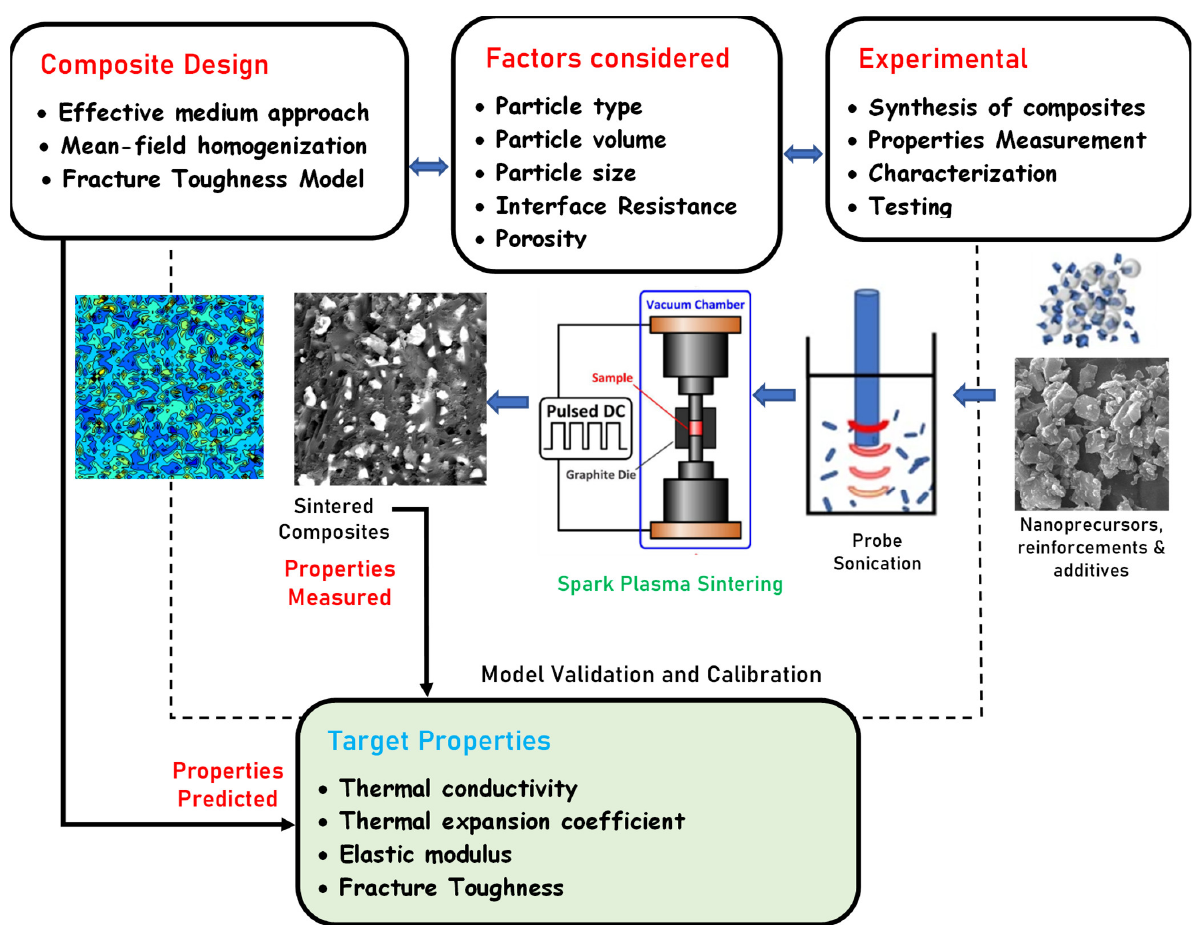
Figure 1. Steps highlighting the computational approach and experimental route taken in the design and development of SiAlON-based composites.